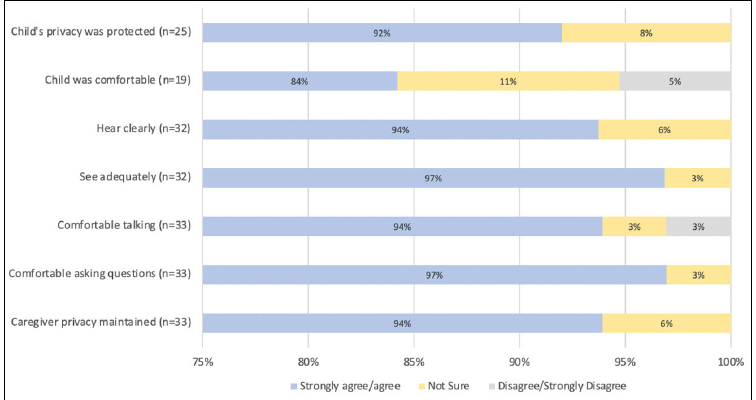
Figure 4. Caregiver experiences with a virtual diagnosis and assessment model of Fetal Alcohol Spectrum Disorder in children.